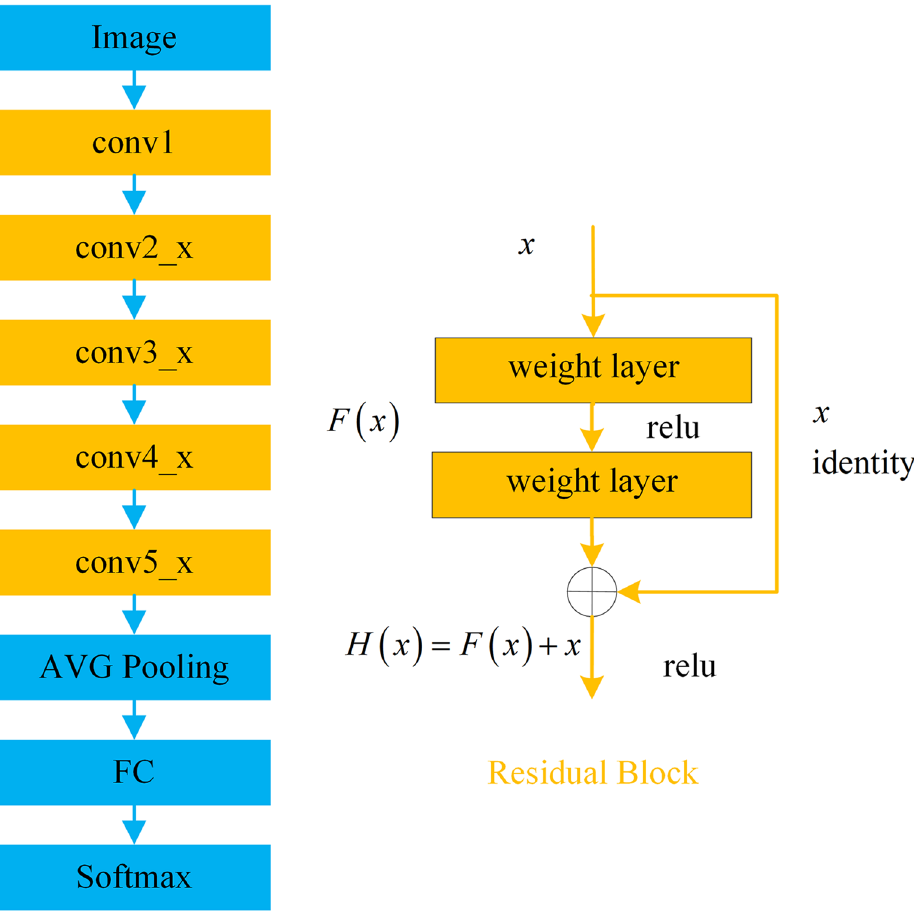
Figure 5. The framework of the ResNet-50.